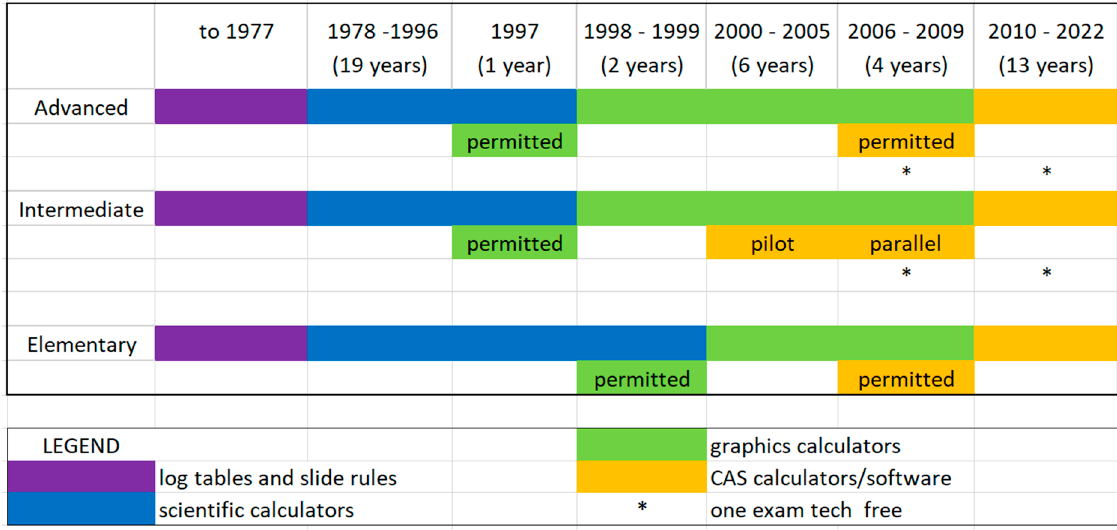
Figure 1. Outline of the changes to allowed technology in VCE mathematics examinations 1970–2022.